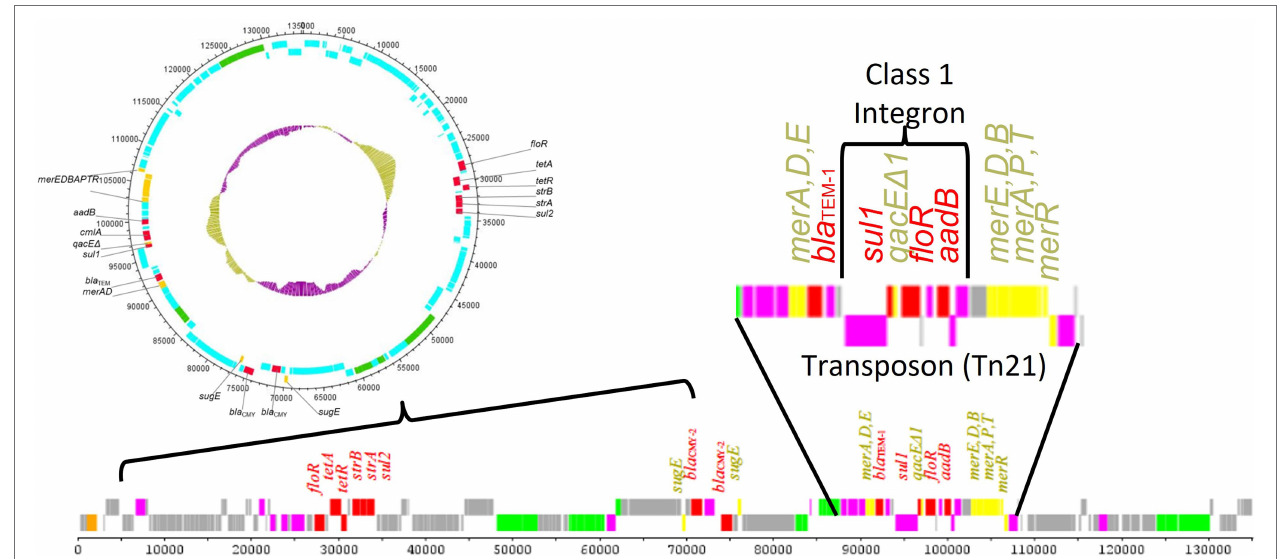
FIGURE 3 | Results of the sequencing of a transmissible antimicrobial resistance plasmid from a Salmonella enterica strain (Han et al., 2012). The plasmid contains multiple antimicrobial resistance (denoted in red) and heavy metal/disinfectant (denoted in yellow) resistance genes, including those carried in a Tn21 transposon. Within the Tn21 transposon, there was a class 1 integron carrying multiple antimicrobial resistance genes. This nesting of MGEs within other MGEs provides significant opportunities for the generation and dissemination of diverse antimicrobial resistance elements. AMR regions and mobile genetic elements also often have a higher G + C content compared to the plasmid backbone as is highlighted in the inner ring of the circular plasmid diagram (gold vs. purple